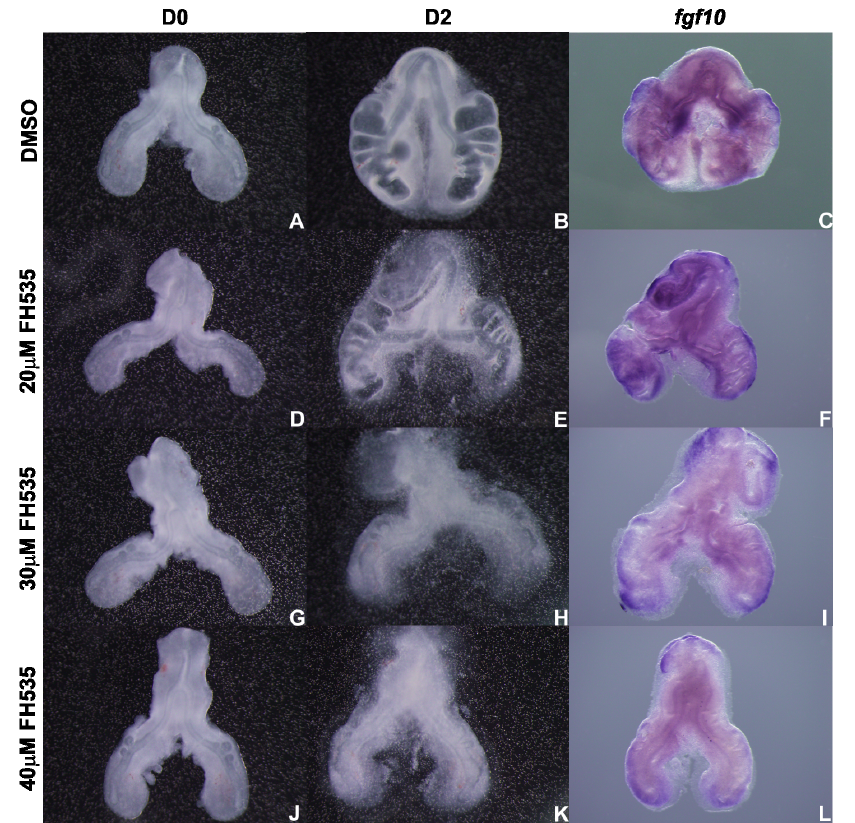
Figure 12. In vitro Wnt signaling inhibition and fgf10 expression. Representative examples of stage b2 lung explant culture, at D0:0h (A, D, G, J) and D2:48h (B, E, H, K) treated with DMSO (A, B), 20 m M (D, E), 30 m M (G, H) and 40 m M FH535 (J, K) and probed with fgf10 (C, F, I, L); n 5 3 for each stage. Magnification: A, B, D, E, G, H, J, K –4x; C, F, I, L –5x.